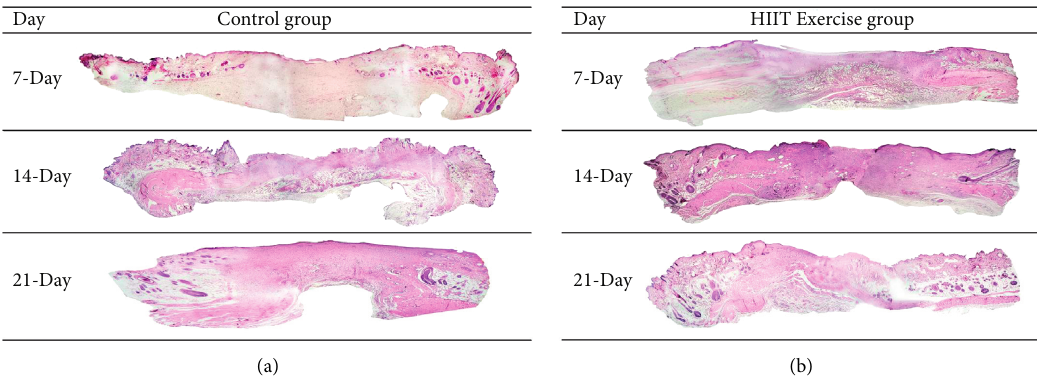
Figure 4: Histological analysis of control (a: × 40) and HIIT exercise (b: × 40) with H&E